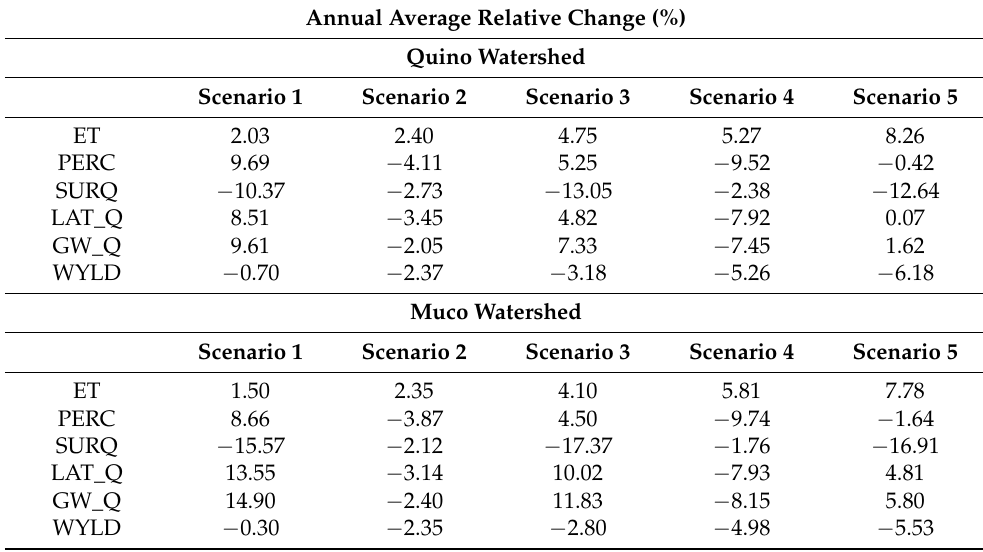
Table A3. Relative change of modeled water cycle parameters for Quino and Muco